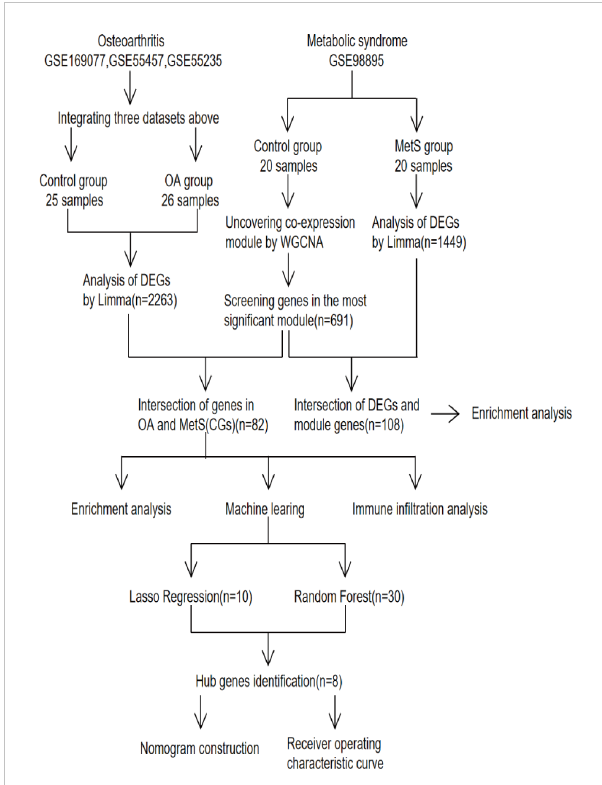
FIGURE 1 Study fl owchart, GSE, gene expression omnibus series; WGCNA, weighted gene co-expression network analysis; Limma, linear models for microarray data; DEGs, differentially expressed genes.